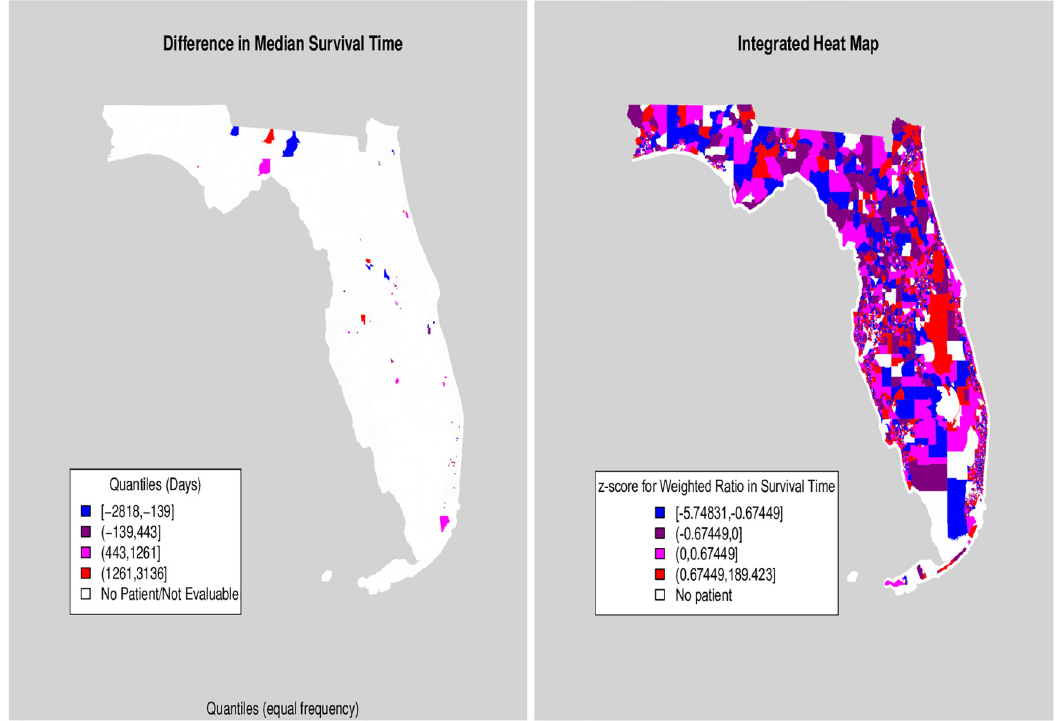
Fig 6. Direct estimate of tract-specific median differences in survival (left). Integrated composite SPADE heat map